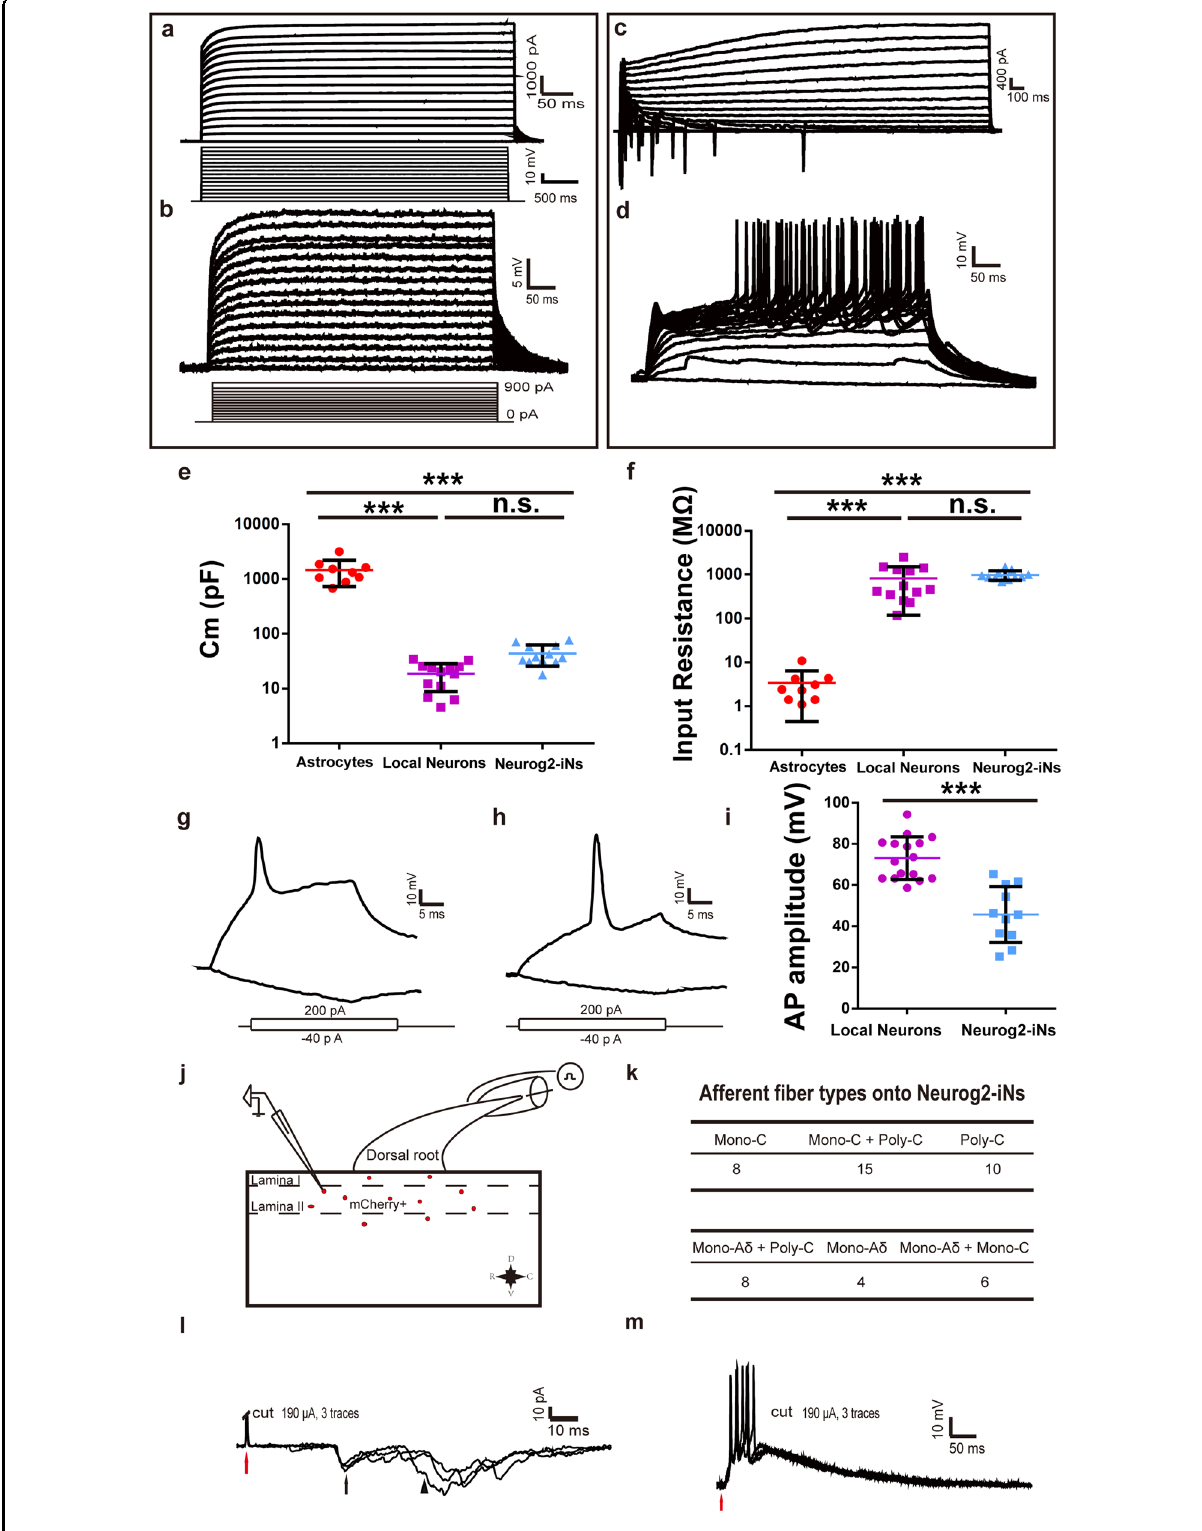
Fig. 5 (See legend on next